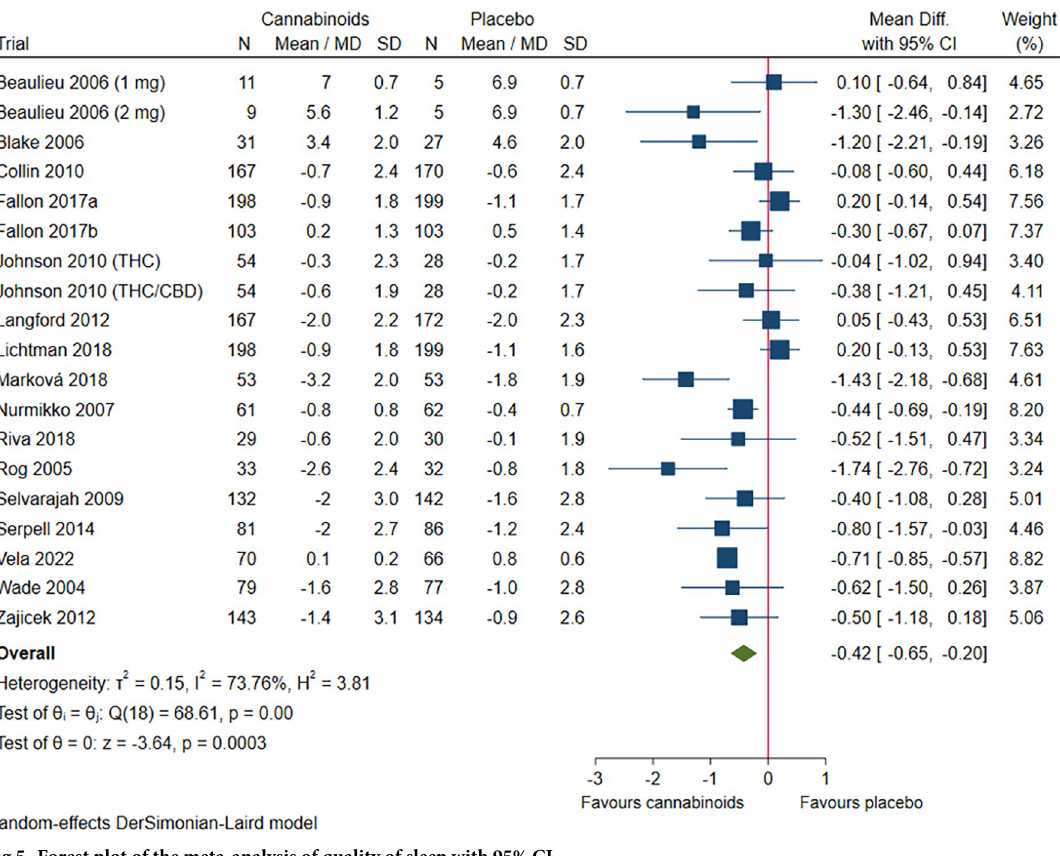
beneficial effect of cannabinoids on quality of life compared with placebo [98]. Mortality was not assessed by any of the trials.